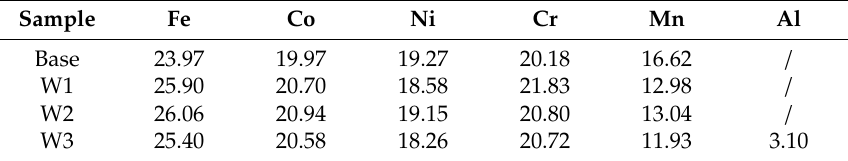
Table 1. EDS analysis (point) of welds (wt.%) compared with that of the base.